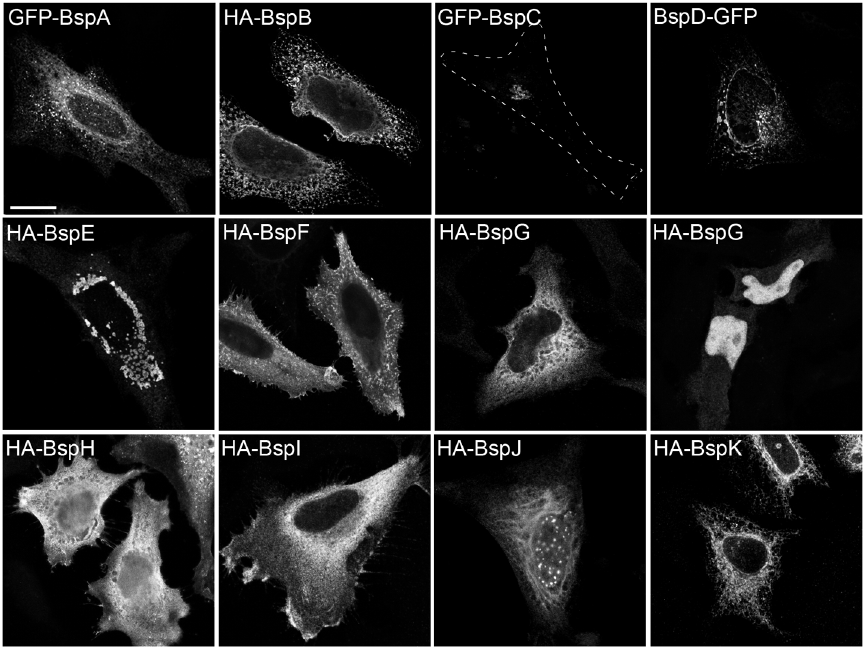
Figure 3. Expression patterns of Brucella Bsp effector proteins in HeLa cells. Representative confocal micrographs of HeLa cells transfected for 12 h with plasmids expressing either GFP- or HA-tagged Bsp proteins. HeLa cells expressing HA-tagged Brucella effectors were immunostained using an anti-HA antibody. The dashed line on the GFP-BspC panel delineates the cell contour. Scale bar, 10 m m.